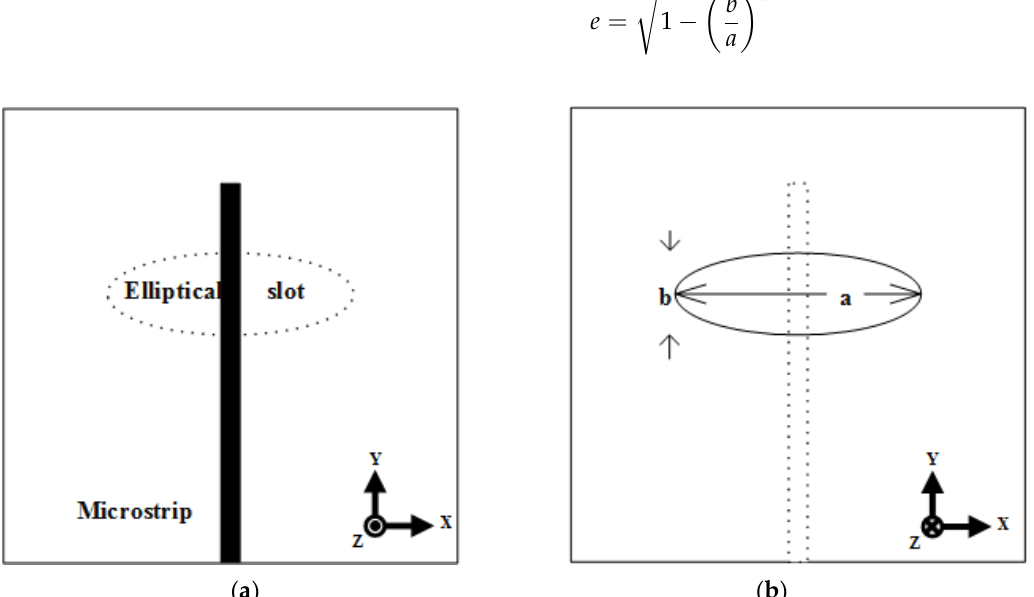
Figure 1. Schematic of open-ended microstrip line with ES: ( a ) Front plane; ( b ) Ground plane.